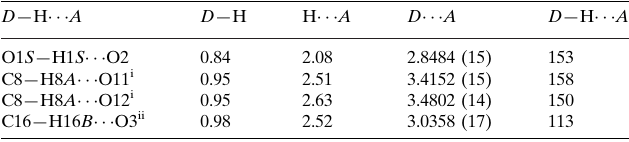
Hydrogen-bond geometry (A˚ , (cid:3)